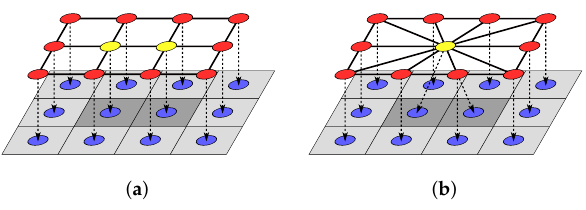
Figure 7. Union on yellow superpixel regions, showing regions and connections before and af- ter operation. ( a ) Superpixel regions before union operation; ( b ) Superpixel region after union